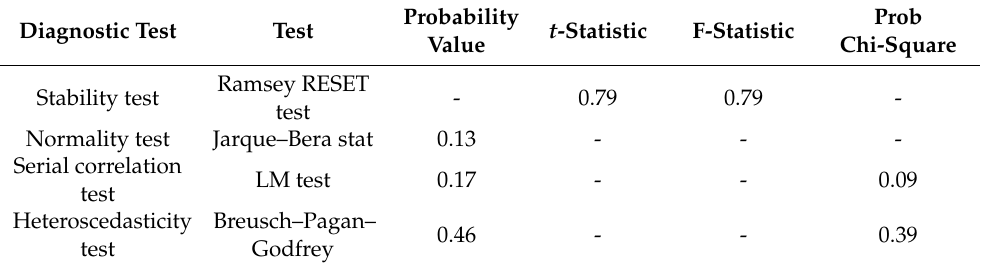
Table 5. Diagnostic